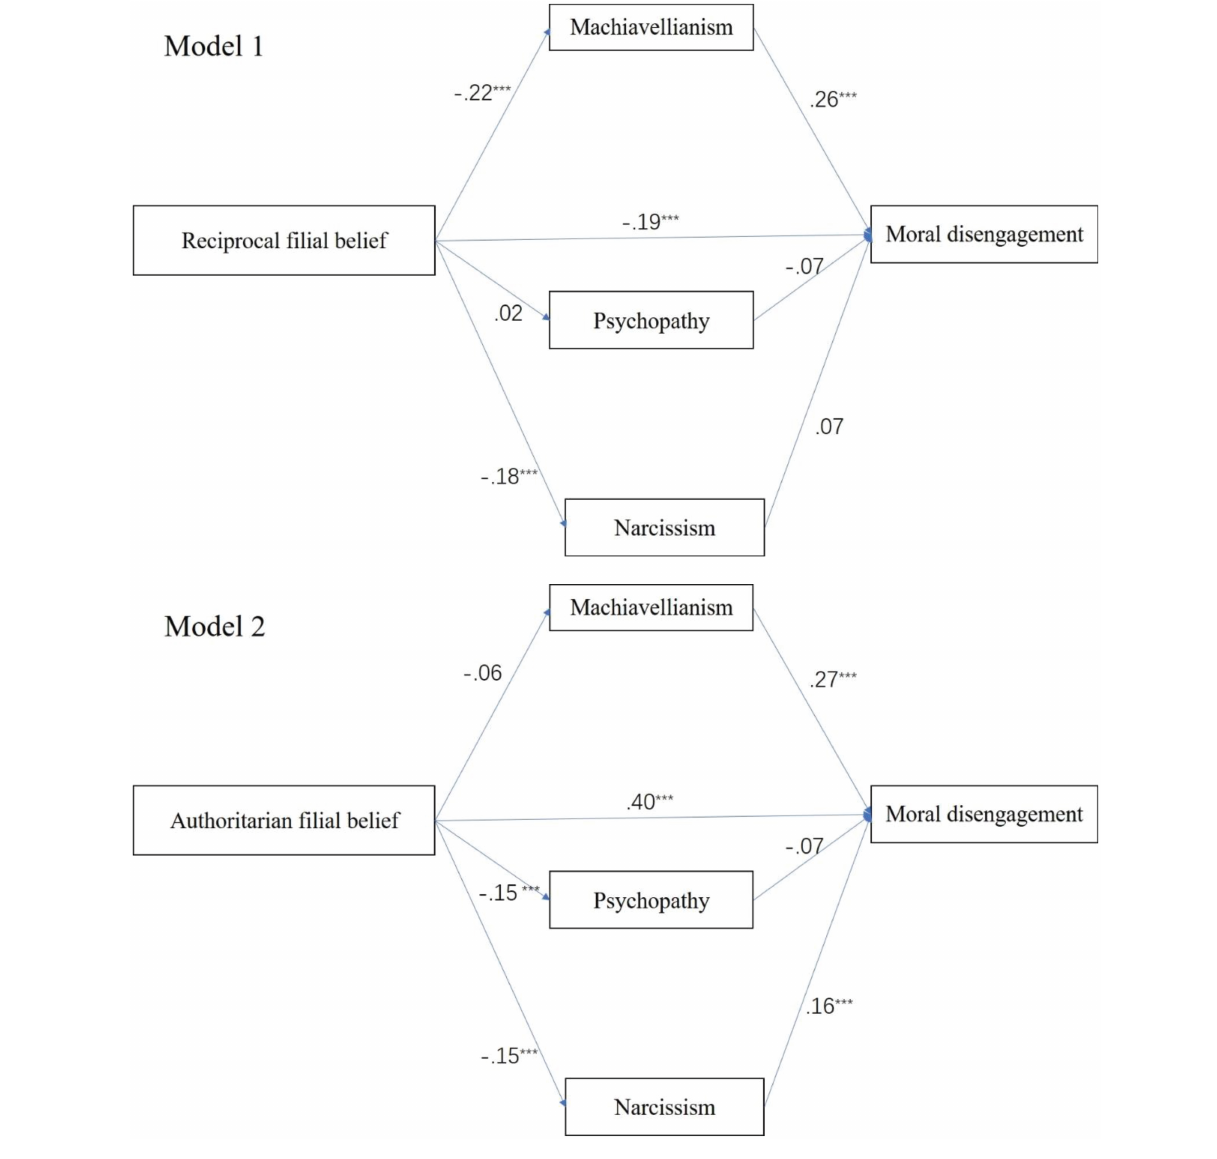
95%CI = − 0.06, − 0.01]), among them, only the mediation effect of narcissism was significant ( b = − 0.02, SE = 0.01, 95%CI = − 0.04, −